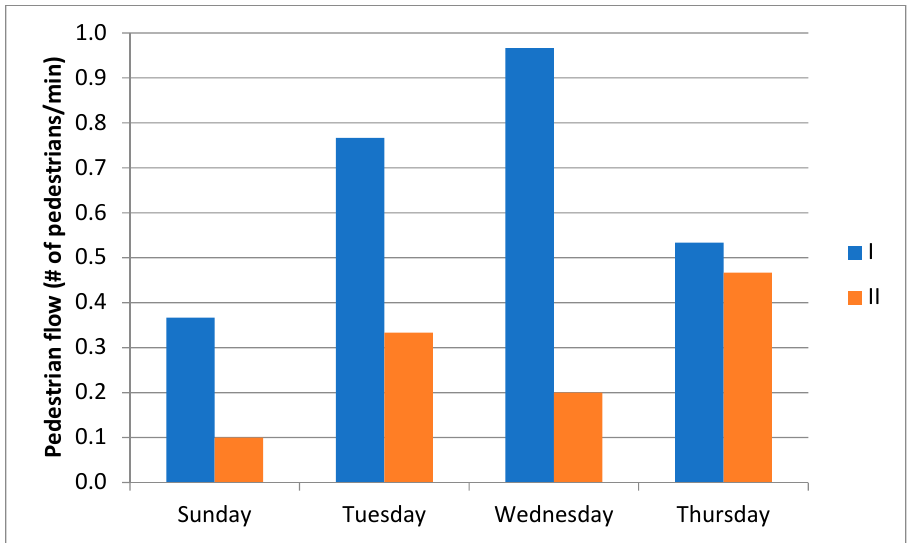
Figure 5. Pedestrian flow on the path during four, one hour long, observations for each lighting application.